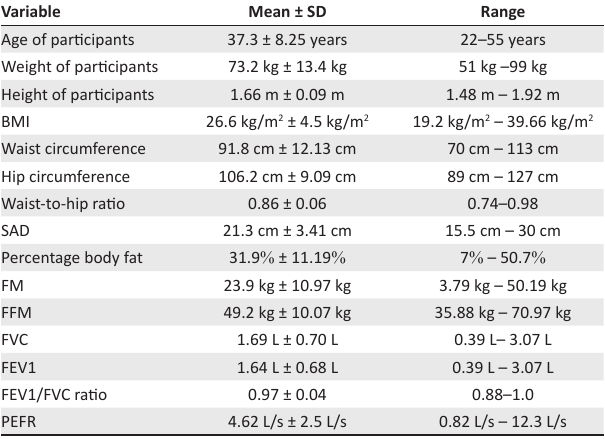
TABLE 1: Summary of mean, standard deviation and range of measured variables ( n =